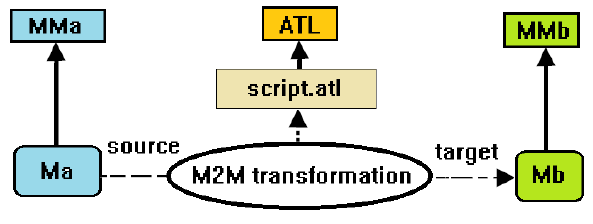
Figure 4 . M2M transformation using